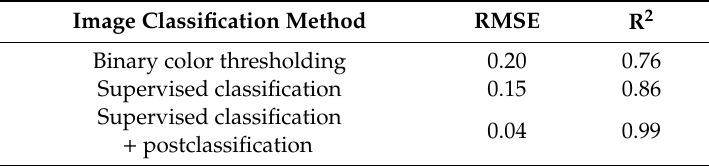
Table 1. Comparison of relative cumulative emergence based on seedling counts and relative cumulative pixels using three di ff erent image analysis methods. Observations and images of R. raphanistrum emergence from September to December were used, totaling 54